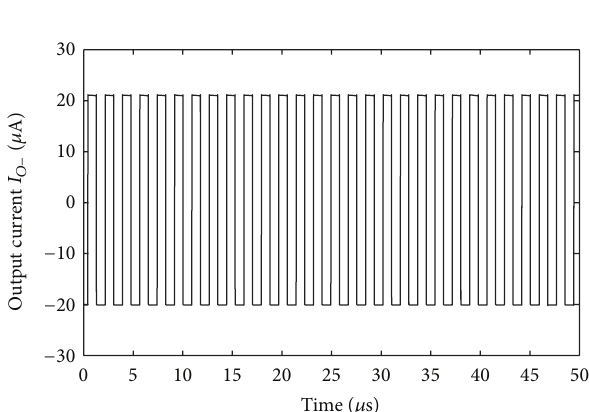
Figure 12: Current 𝐼 𝑂− of pulse generator.